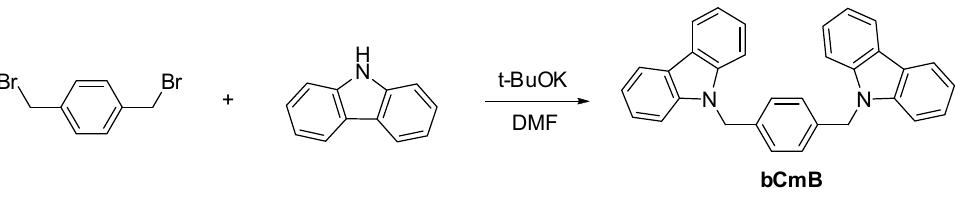
Figure 1. Synthesis of bCmB.